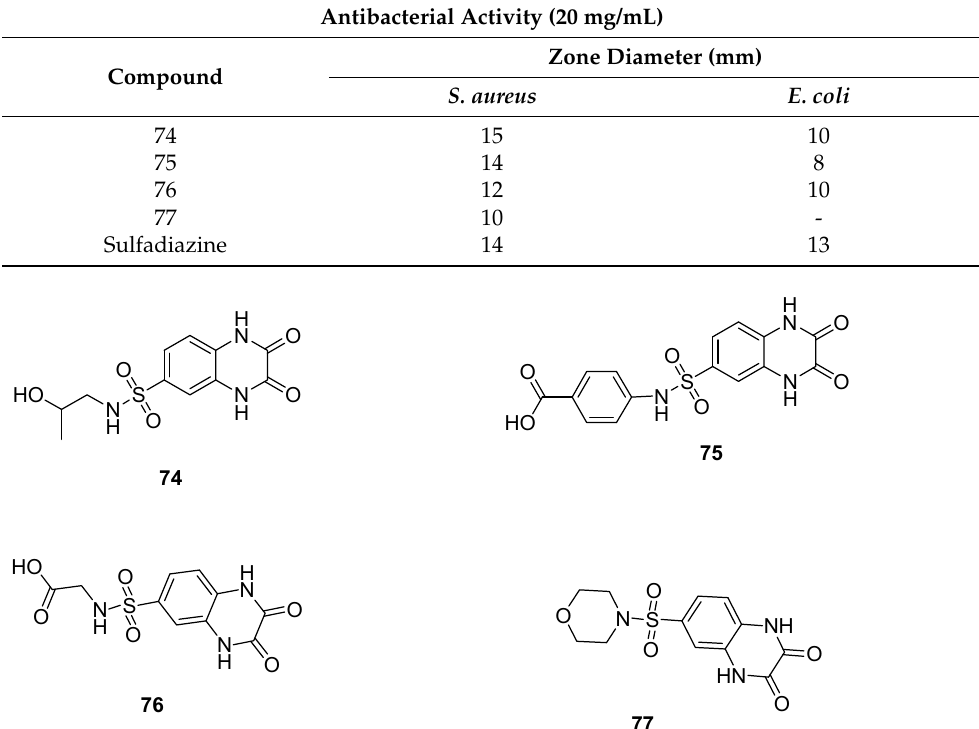
Table 5. Antibacterial activity of quinaxoline sulfonamide derivatives 74 – 77 .